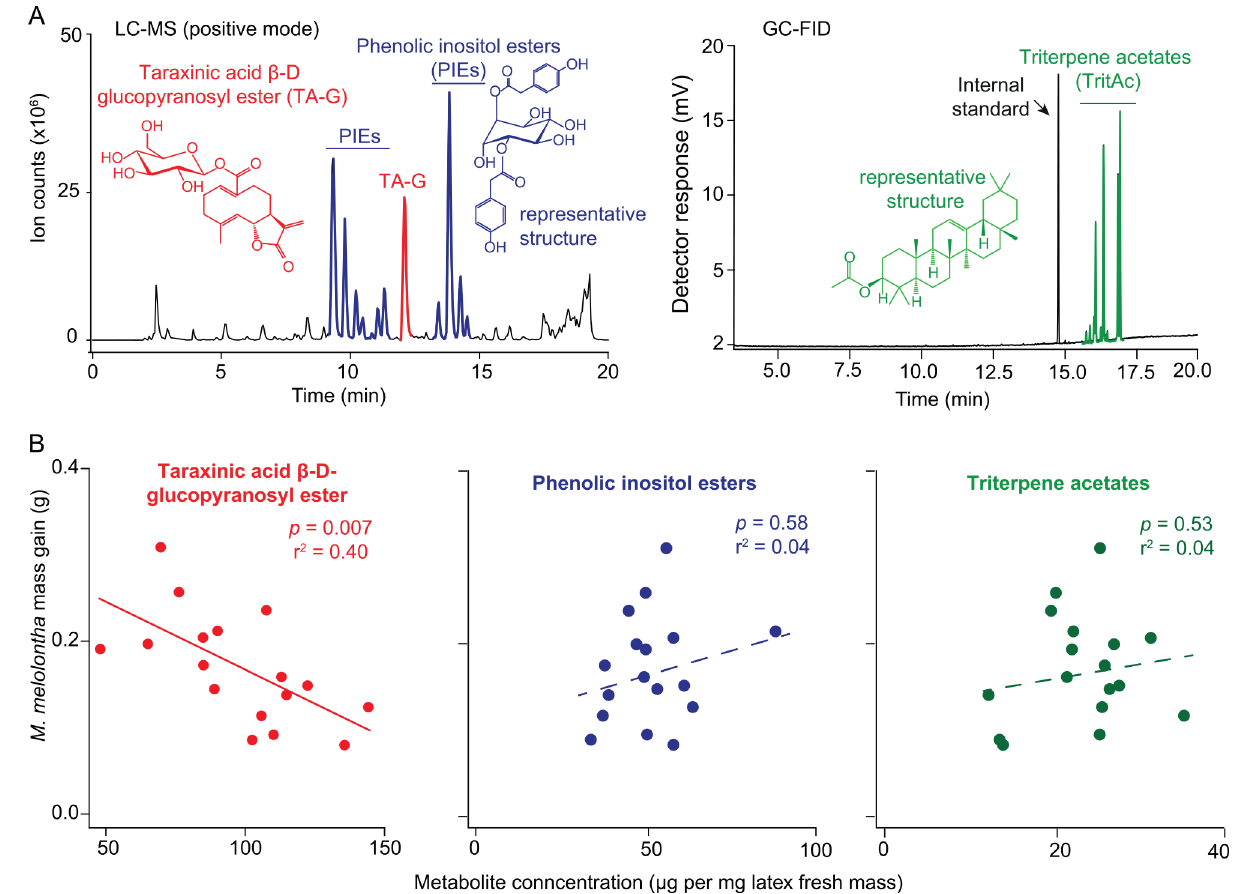
Fig 1. M . melolontha growth correlates negatively with the concentration of the latex metabolite TA-G. A. Representative liquid chromatography- mass spectrometry (LC-MS) chromatogram of a latex methanol extract (left panel) and gas chromatography-flame ionization detector (GC-FID) chromatogram of a latex hexane extract (right panel) depicting the three major classes of latex secondary metabolites in T . officinale . LC = liquid chromatograph. MS = mass spectrometer. GC = gas chromatograph. FID = flame ionization detector. B. After 11 d of feeding, growth of M . melolontha larvae on 17 T . officinale genotypes was negatively correlated with TA-G concentration in the root latex (linear model, p = 0.007, left panel). M . melolontha growth was not correlated with the total concentrations of PIEs (middle panel) or TritAcs (right panel). Each data point represents the mean M . melolontha growth rate of 12 independent replicates of one T . officinale genotype. Underlying data can be found in S1 Data. (Fig 1B, middle and right panel, p = 0.58 for PIEs; p = 0.53 for TritAcs, n = 17, linear models).